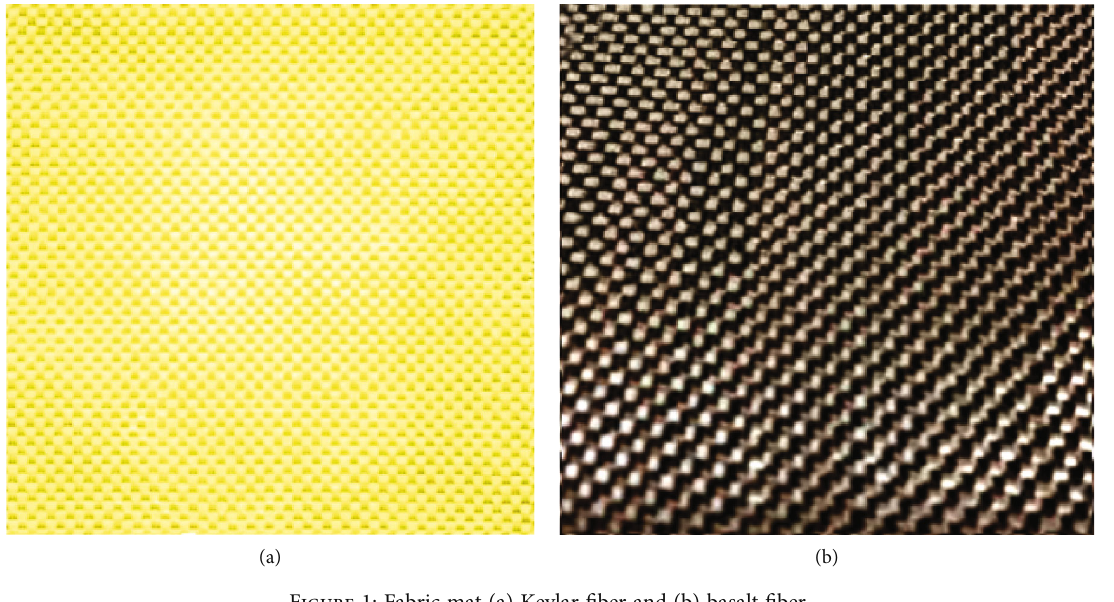
Figure 1: Fabric mat (a) Kevlar fi ber and (b) basalt fi ber. Table 1: Mechanical and thermal properties of the fabric